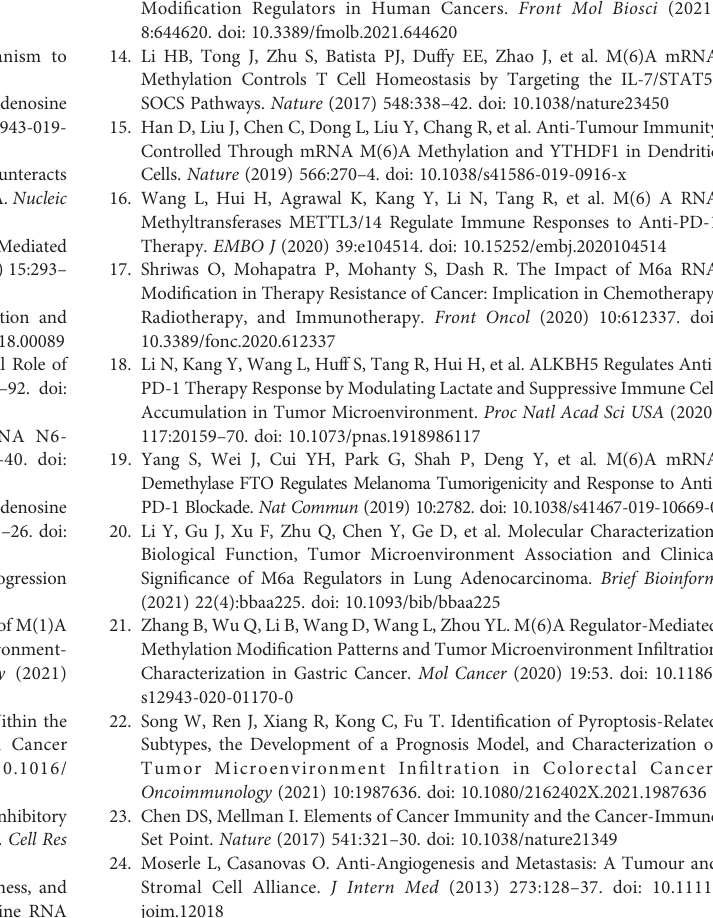
network. (D) The correlation analysis of regulator co-expression. (E) Differential analysis of m6A regulators in high- and low- FTO expession subgroups. Supplementary Figure 2 | Landscape of 15 m6A regulators in TCGA subtypes of GBM. Supplementary Figure 3 | Immunohistochemistry of m6A regulators protein in normal brain tissue and glioblastoma. Supplementary Figure 4 | The m6A methylation patterns in CGGA cohort. (A) The consensus distributions for k (1-9). (B) Distribution of IDH1 molecular subtype in different m6A clusters. (C) Distribution of histological subtype in different m6A clusters. (D) Unsupervised clustering analysis in CGGA cohort. (E) Kaplan- Meier OS analysis in the two m6A clusters of CGGA cohort. (F) Immune cell abundance in the 2 m6A clusters of CGGA cohort. (G) Enrichment score of TME signatures in the 2 m6A clusters of CGGA cohort. Supplementary Figure 5 | Characteristics of m6A related phenotypes. (A) Unsupervised clustering analysis of 41 signature genes of m6A methylation pattern. (B) Differential expression of 15 m6A regulators between the 2 gene- clusters. (C) Distribution of IDH1 molecular subtype in different gene- clusters. (D) Distribution of histological subtype in different gene-clusters. (E) Kaplan-Meier OS analysis in the gene-clusters. Supplementary Table 1 | The m6A methylation pattern signature genes. Supplementary Table 2 | The prognosis-related signature